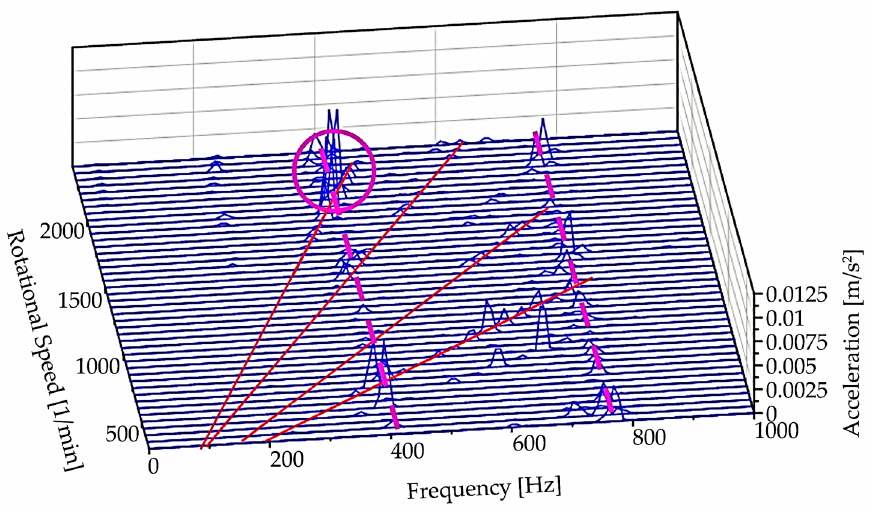
Figure 18. A series of spectra and the beam character of the excitation sources (indicated by red lines).